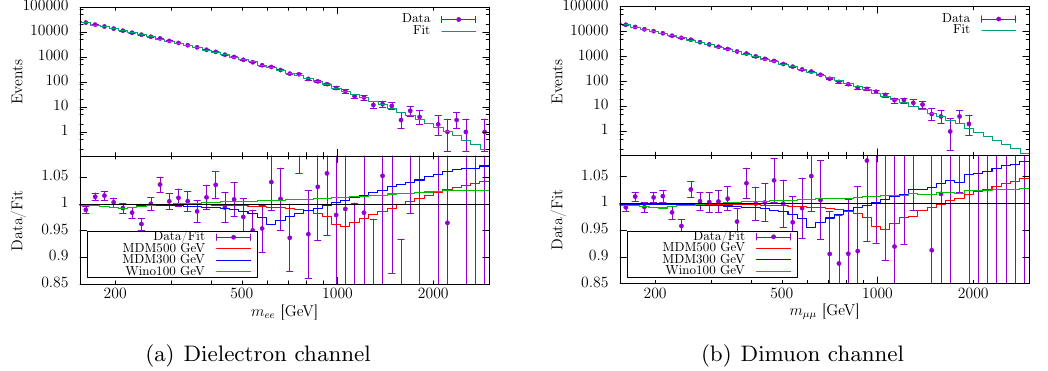
Figure 4 . Fitting the observational data by the SM background based on the function in eq. (3.1) for (a) dielectron and (b) dimuon channels with m ‘‘ being the lepton invariant mass. The data of 36 fb (cid:0) 1 at the 13 TeV LHC is used. Bottom panel in each (cid:12)gure shows the ratio between